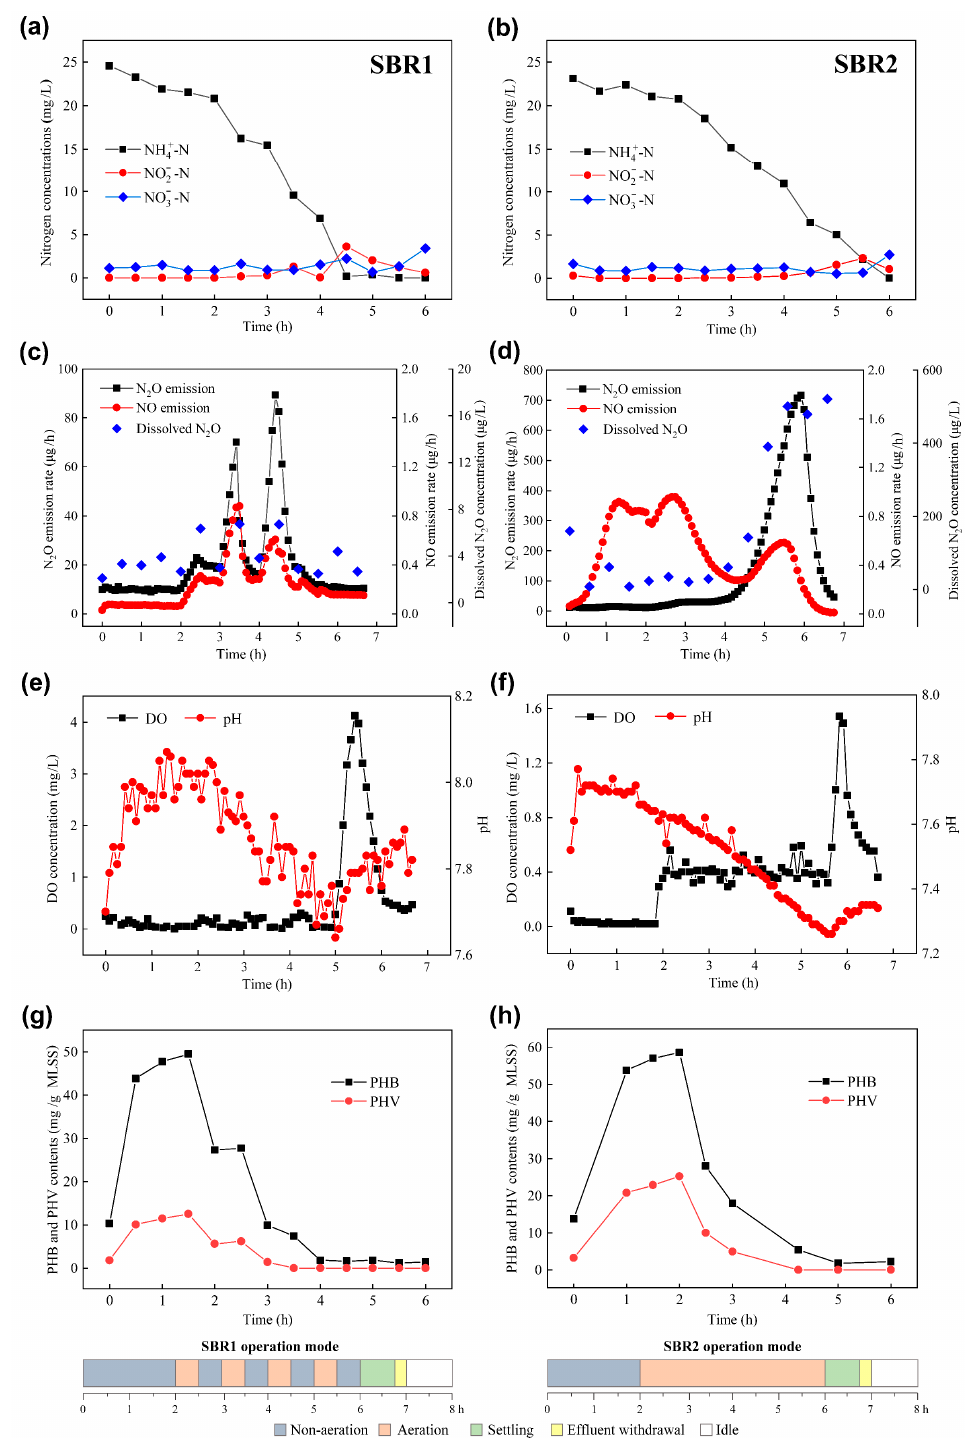
Figure 2. Performance evaluations in a typical cycle of both SBRs: ( a , b ) variations of NH + N and NO − -N concentrations; ( c , d ) variations of N 2 O and NO emission rates, and dissolved N 2 O concentrations; ( e , f ) variations of dissolved oxygen (DO) and pH; ( g , h ) variations of polyhydroxyalkanoates (PHA, including poly- β -hydroxybutyrate (PHB) and polyhydroxy valerate (PHV)) contents.